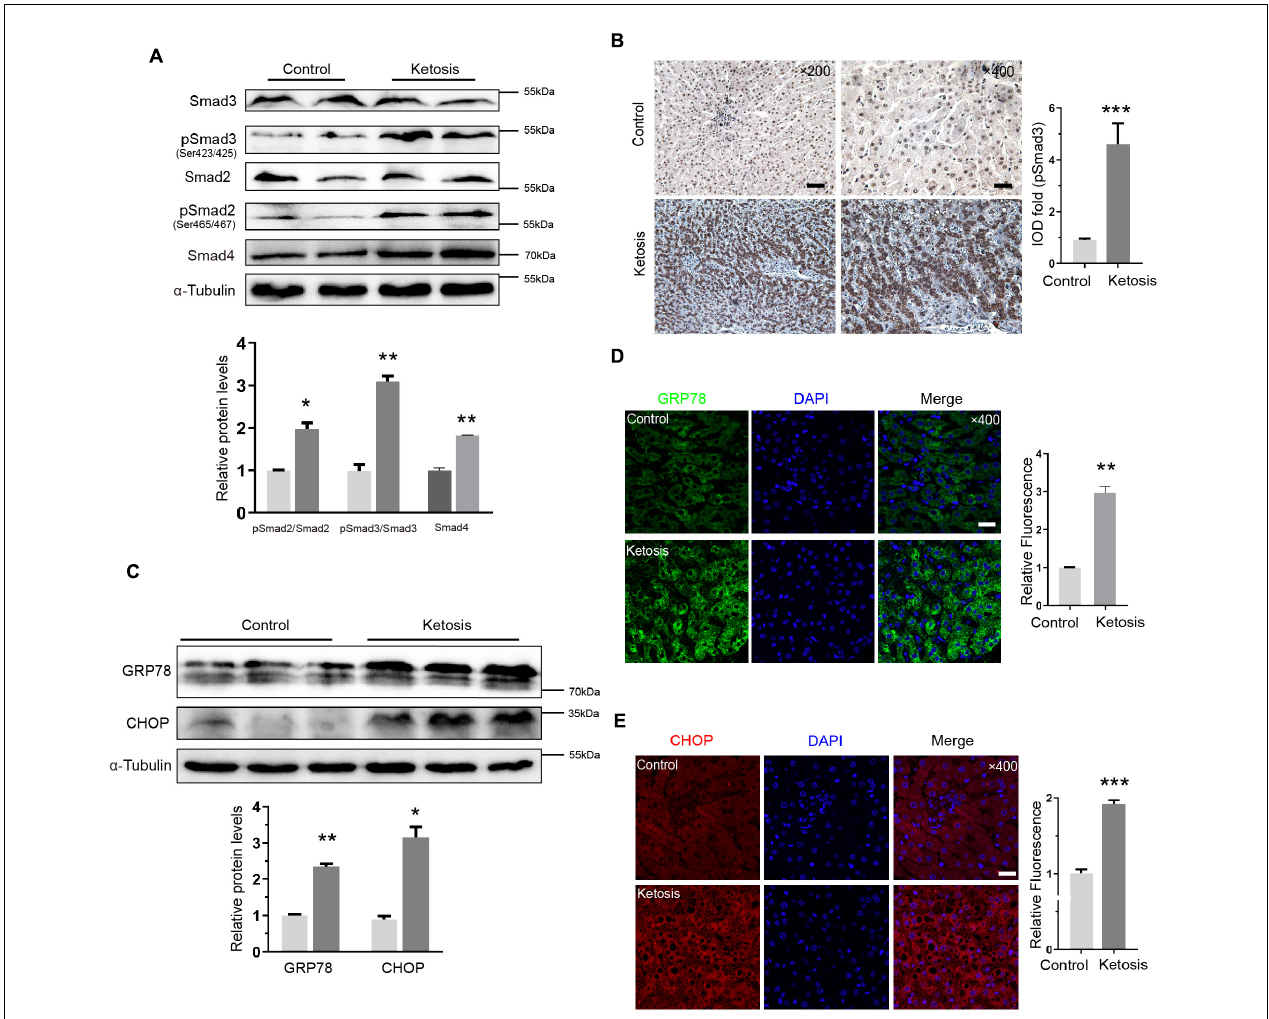
FIGURE 3 | Smad3 activation and elevated ER stress in liver of ketotic cows. (A) Protein expression of Smad2/3 signaling pathway components, and quantitative analysis was shown in the lower panel ( n = 4). (B) Immunohistochemistry for pSmad3 and analysis in right panel. Dark brown-stained areas represented activation and nuclear translocation of pSmad3. (C) GRP78 and CHOP, as ER stress marker proteins, were increased significantly by Western blot, and quantitative analysis was shown in lower panel ( n = 3). (D) Strong expression of GRP78 was detected in cytoplasm by immunofluorescence. (E) CHOP was detected both in nucleus and cytoplasm by immunofluorescence. Data are presented as means ± SEM, ** P < 0.01, *** P < 0.001. Scale bar = 50 µ m at × 200 or 20 µ m at × 400